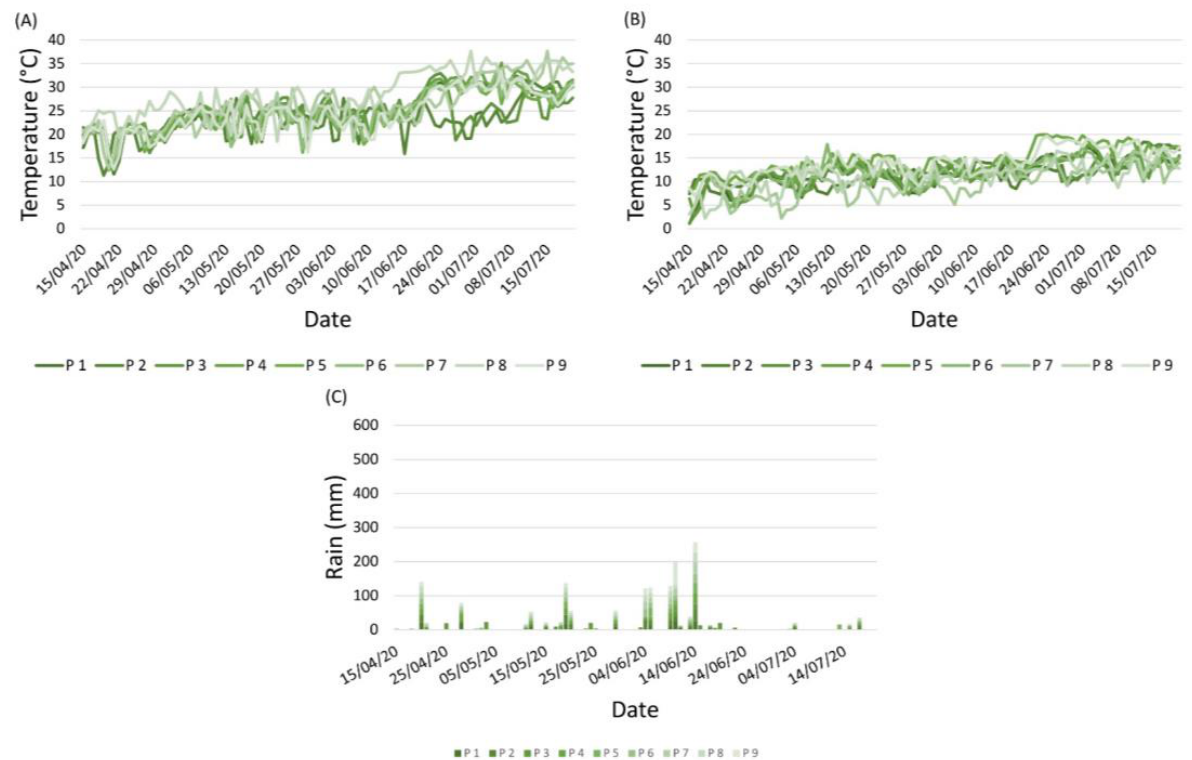
Figure 1. Weather conditions occurring from April to July 2020 in the nine vineyards (P1–P9): daily maximum temperature ( A ), minimum temperature ( B ), and rainfall ( C ). Different shades/colours represent different vineyards (P1–P9).